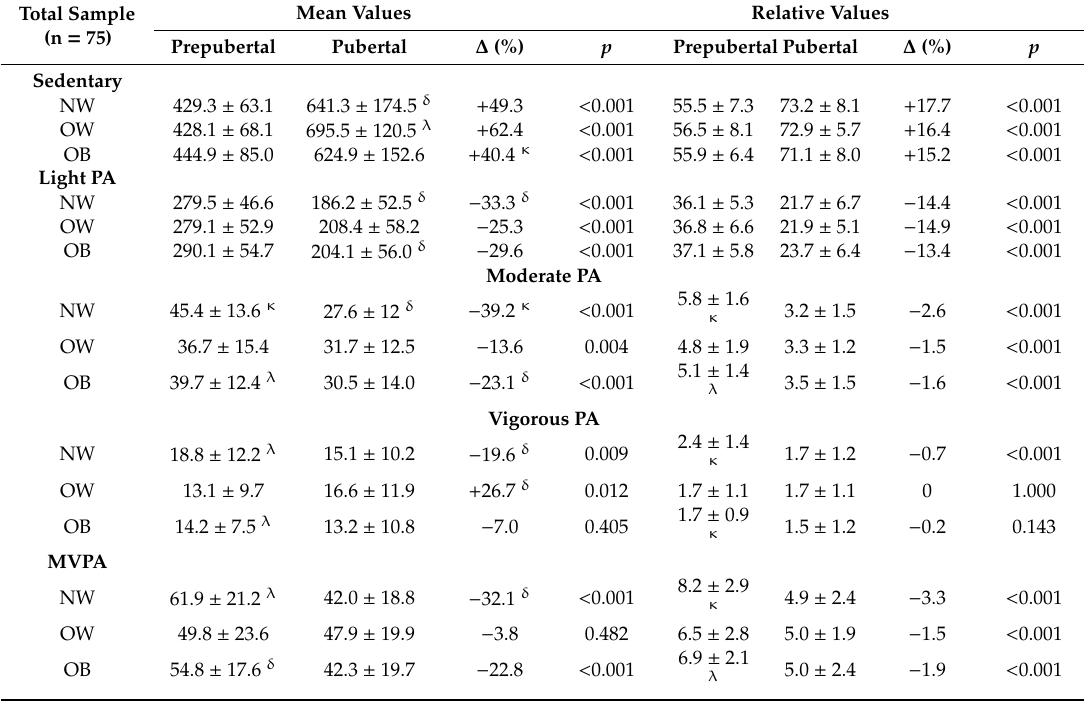
Table 4. Comparison of physical activity levels and minutes of practice between prepubertal and pubertal periods according to BMI groups in the longitudinal sample ( n =